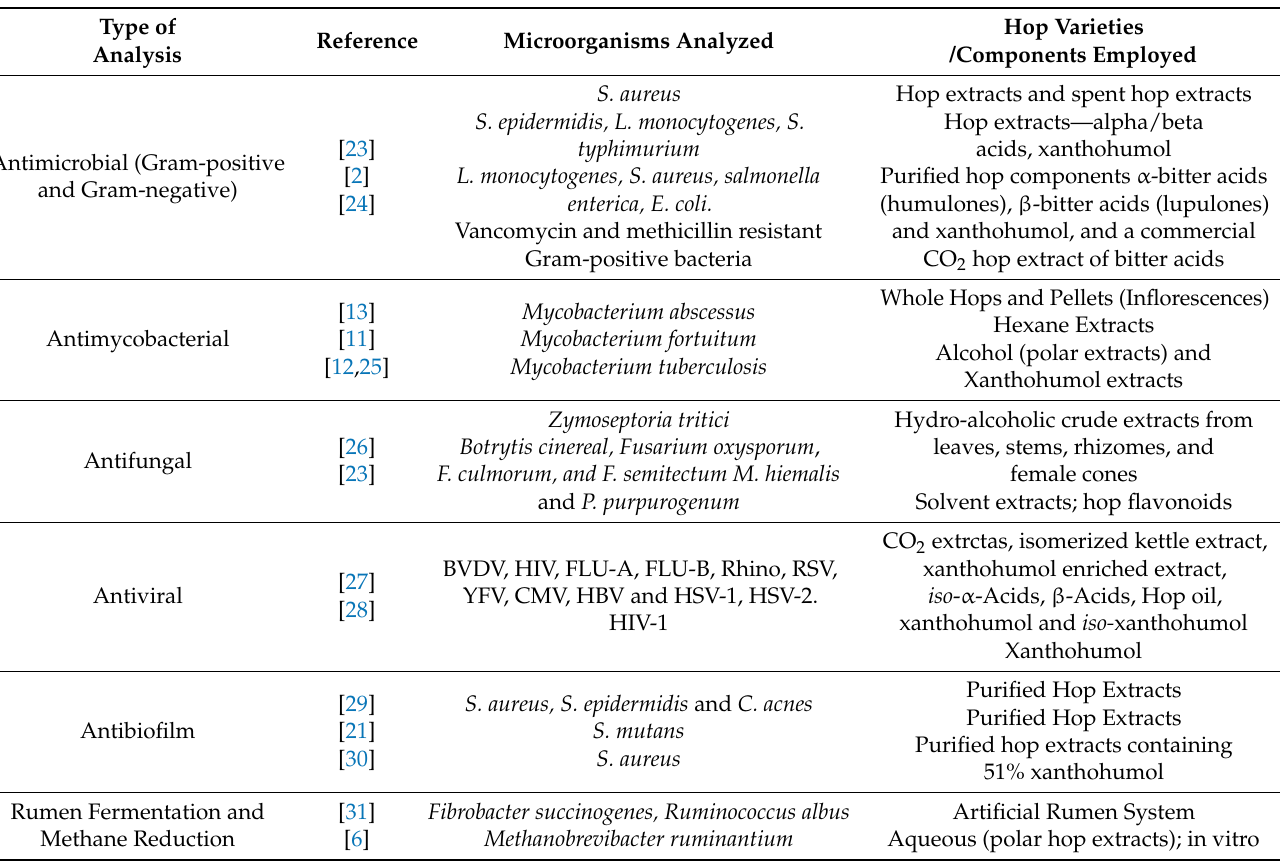
Table 4. An overview of recent and pertinent antimicrobial, antifungal, antiviral and antibiofilm studies concerning the use of hops and their extracts. The authors found no references to studies that investigated the antimicrobial effect of hops effect against Mycoacterium bovis